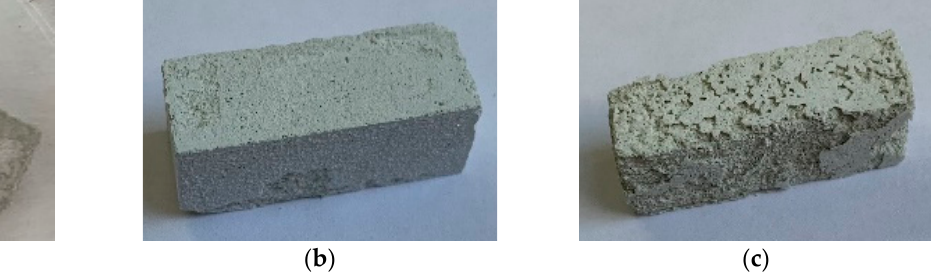
Figure 9. Photos ( a ) of the MPP-Z compound after its heat treatment at 180 °C, including after soaking in solutions of ( b ) 0.7 wt.% and ( c ) 7.0 wt.% hydrogen peroxide.